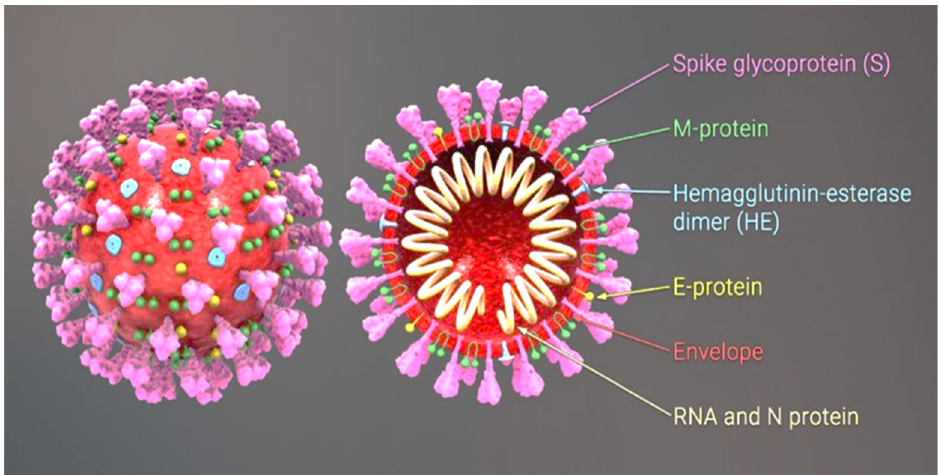
Figure 1. The structure of a coronavirus [4]. E—envelope; M—membrane; S—spike glycoproteins, which allow viral particles to bind to receptors on the host cell membranes.